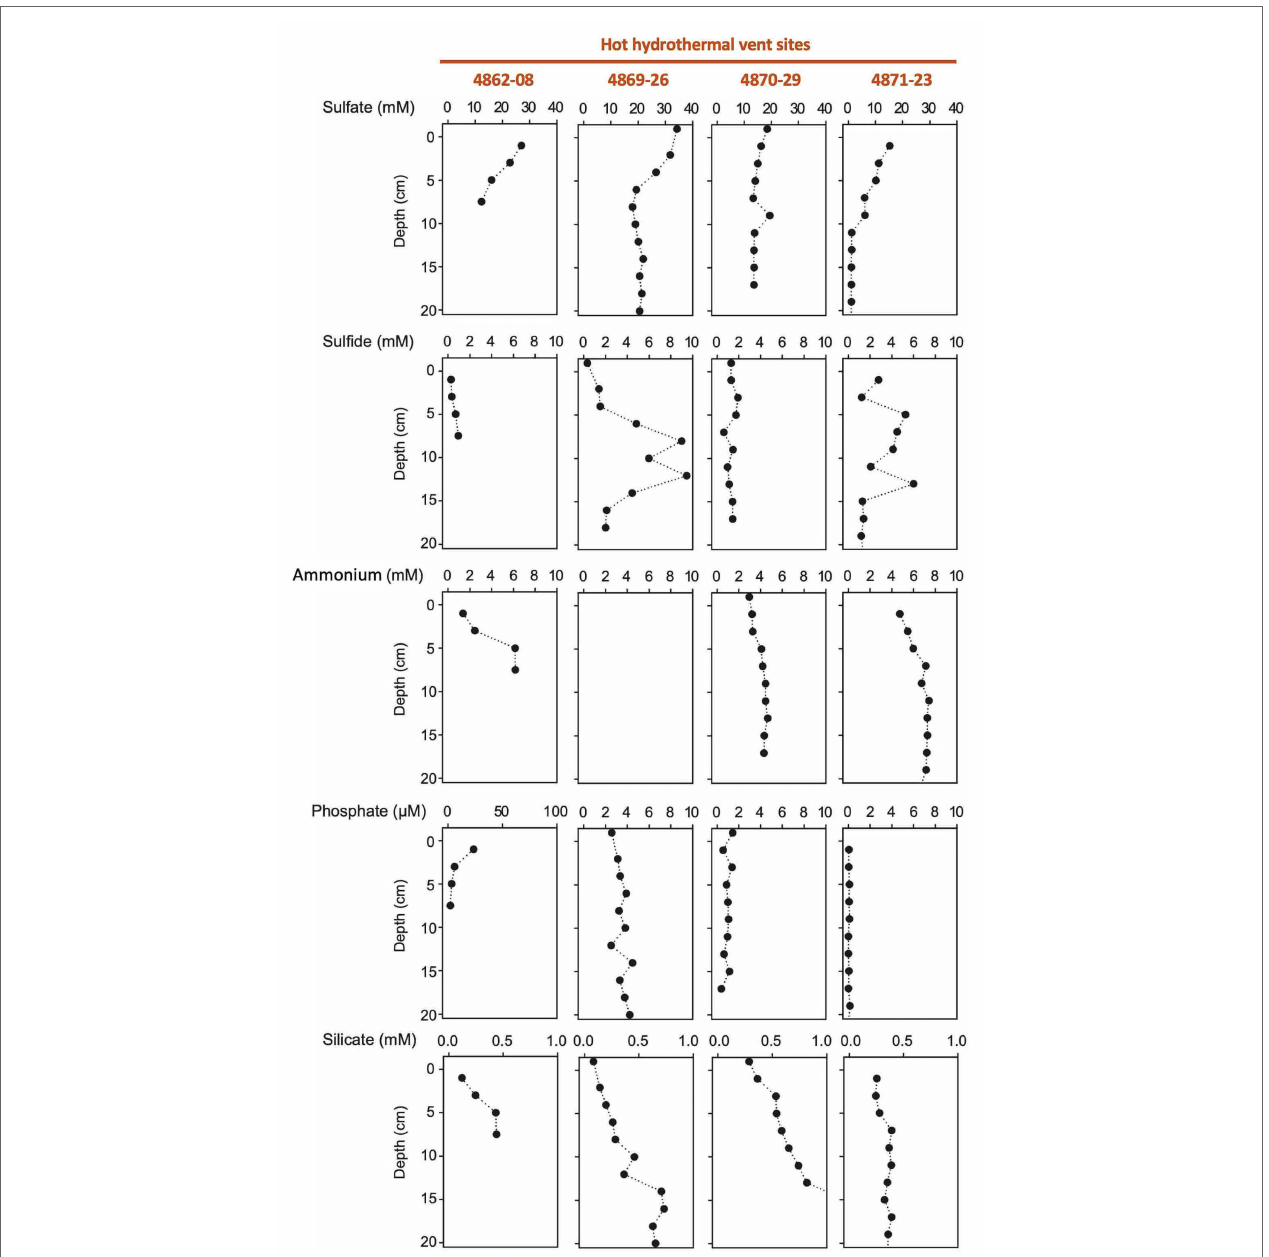
FIGURE 4 | Porewater concentration profiles of sulfate, sulfide, ammonium, phosphate, and silicate in four hydrothermal